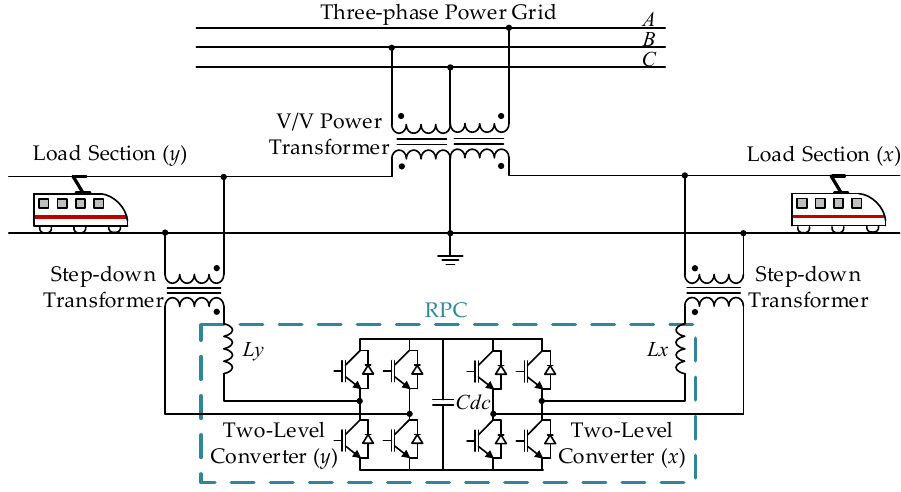
Figure 1. Typical rail power conditioner (RPC) connection with two-level back-to-back converters and open-delta (V/V) power